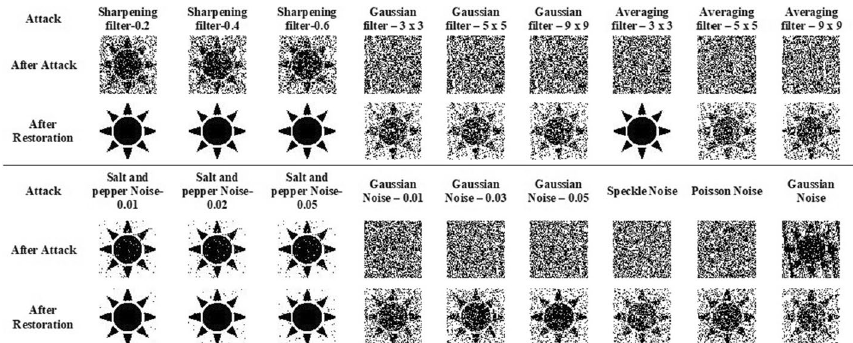
Fig. 14 Attacks and recovery of Logo2 before and after